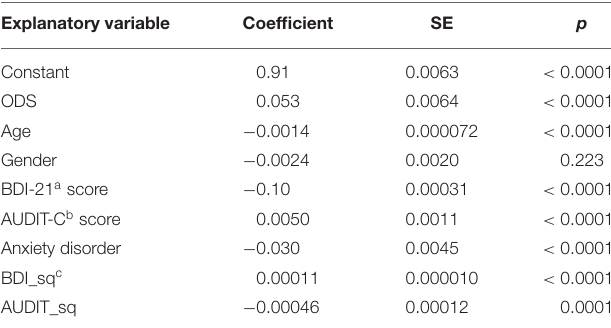
TABLE 4 | Results of the tobit regression model with the 6-month follow-up data of the Ostrobothnian Depression Study (ODS) sample together with Finnish Health 2011 Survey